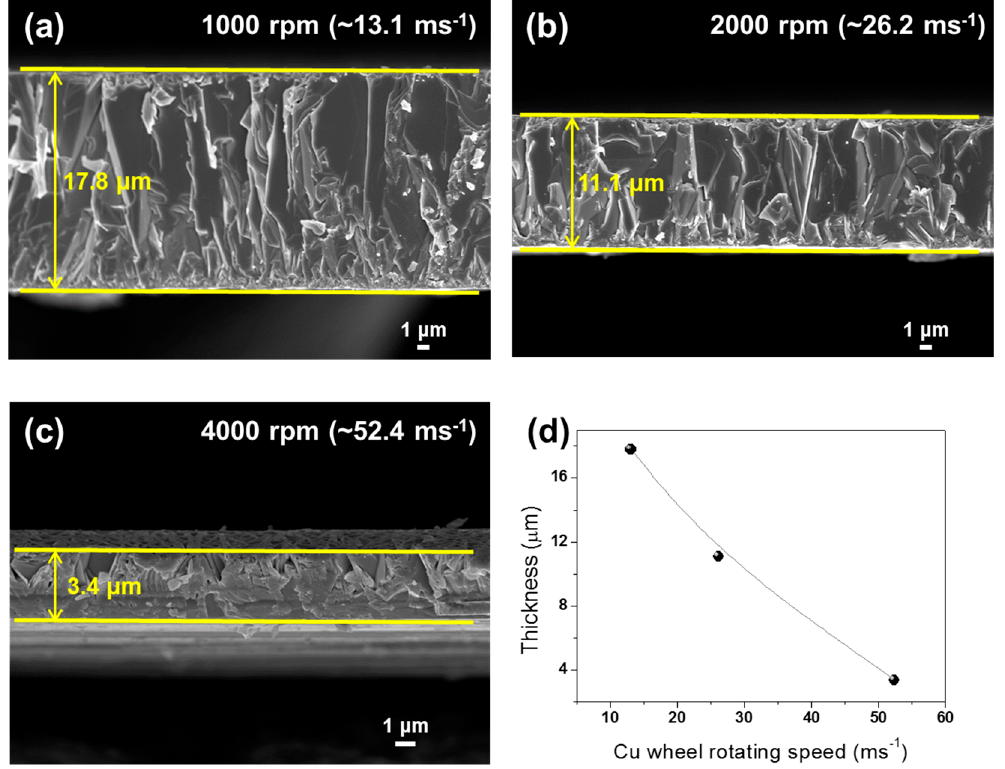
Figure 1. The cross-section SEM images of the melt-spun ribbons with varying Cu wheel rotation speed during melt spinning (MS) process. ( a ) 1000 rpm; ( b ) 2000 rpm; ( c ) 4000 rpm and ( d ) Plot of thickness with Cu wheel rotation speed (ms − 1 ).